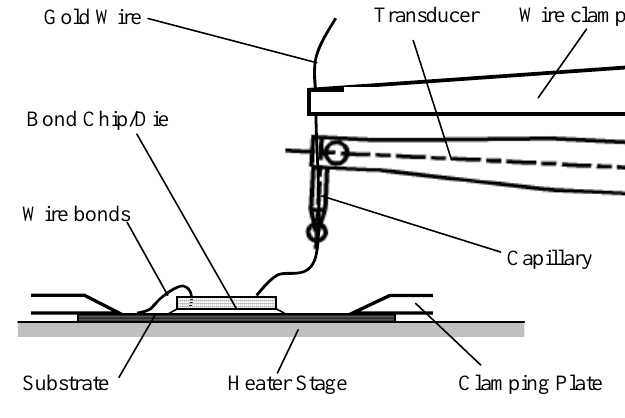
Figure 2. The schematic depiction of electrical interconnect packaging of wire bonder.